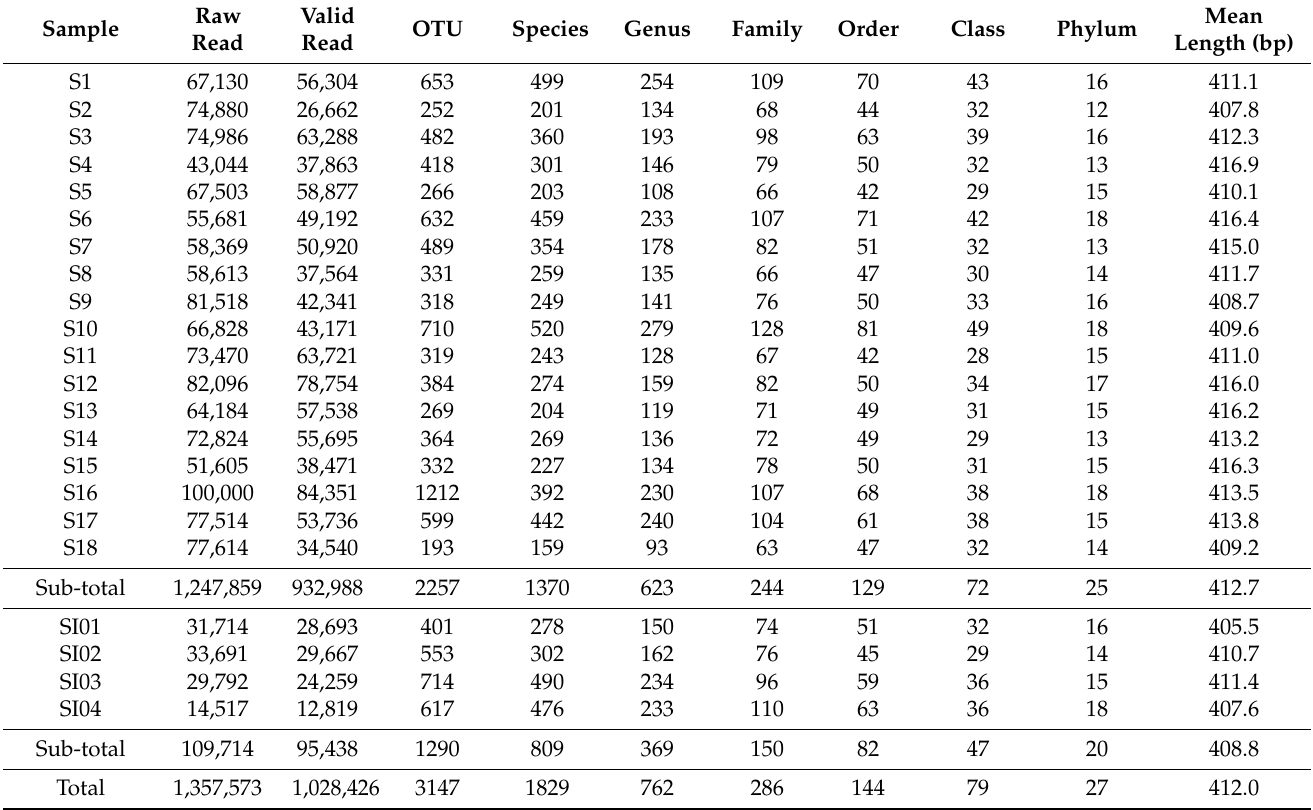
Table 3. Numbers of MiSeq-generated V3-V4 region reads, 97% similarity-based OTUs, OTU-derived species, genera, families, orders, classes and phyla in each sample. The sub-total and total numbers